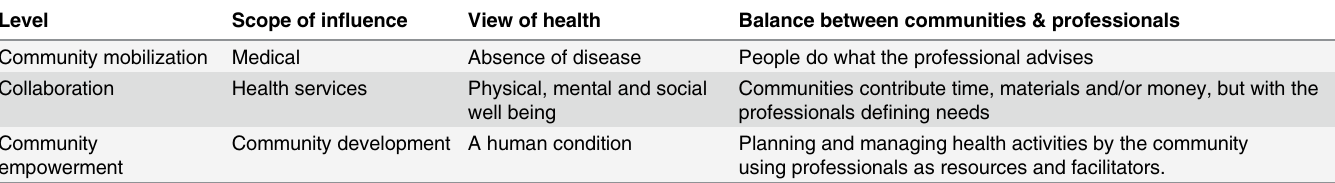
Table 10. Balance of power and the continuum of community